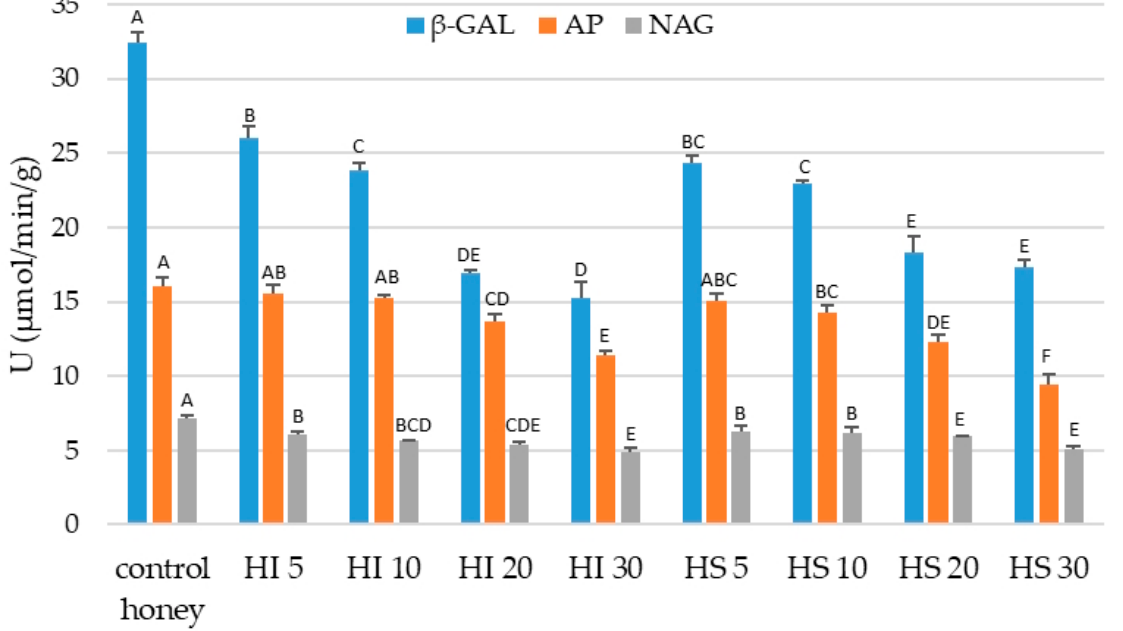
Figure 3. The effect of adulterant addition on the activity of selected native hydrolytic enzymes of honey. A,B,C,D,E,F —samples marked with different superscript letters are statistically significant different within the control honey and adulterated samples (mix only) (separately within individual enzymes) (Tukey’s honest significant difference test, p < 0.05).